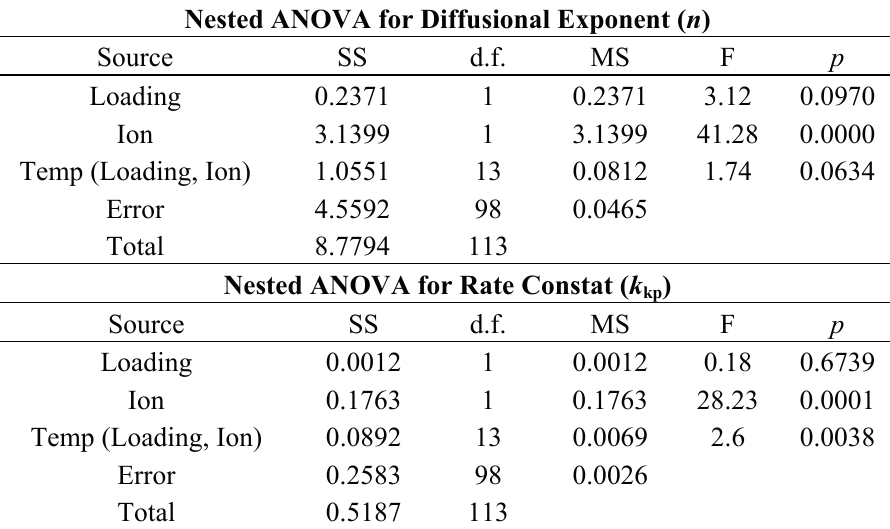
Table 3. Nested ANOVA (analysis of variance) for the effect of loading method, cation (where SS = sum of squares, d.f. = degrees of freedom, type and temperature on n and k KP MS = mean of squares, F = f-statistic and p = p